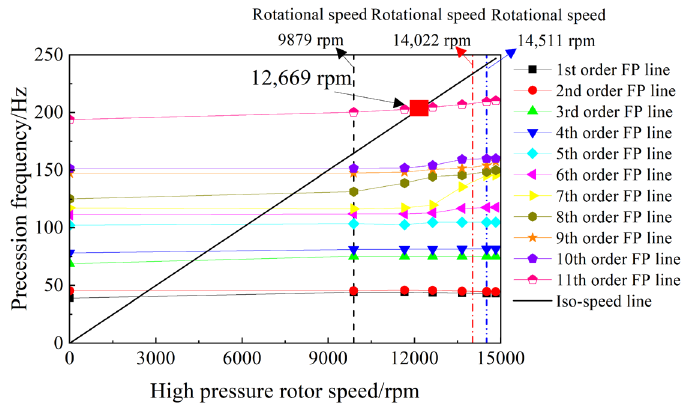
Figure 8. Campbell diagram of high-pressure rotor excitation (FP: forward precession). The high- and low-pressure rotor speed and modal mode shape corresponding to each critical speed are shown in Table 3. Table 3. The critical speed and mode shape of the whole engine.